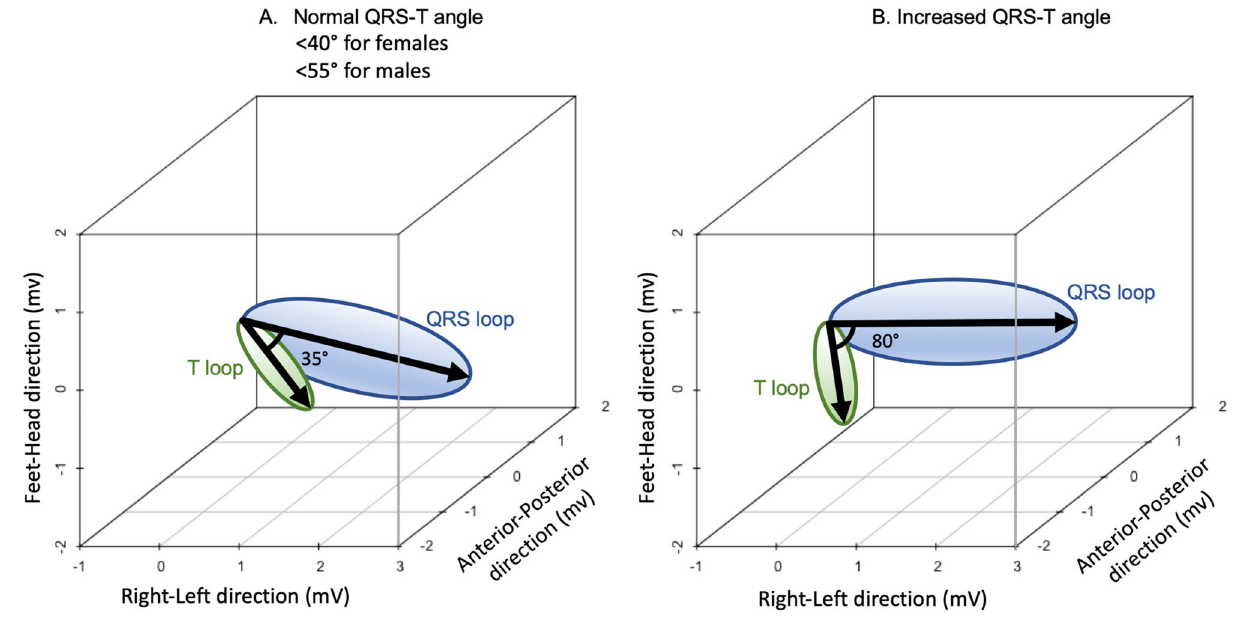
Figure 1. Schematic illustration of the QRS-T angle, a vectorcardiographic measure derived from a digital resting 12-lead ECG. The vectorcardiogram represents the electrical activity in millivolts (mV) in three dimensions along the left–right, feet-head and anterior–posterior axes. The QRS loop (blue) and T loop (green) represent the direction and peak magnitude of depolarization and repolarization, respectively, of the left ventricle. The thick arrows show the largest magnitudes of the respective loops. The angle in three-dimensional space between the largest magnitude of the QRS loop and T loop is referred to as the spatial peaks QRS-T angle. ( A ) Schematic example of a normal QRS-T angle of 35° in a healthy volunteer. ( B ) Schematic example of an increased QRS-T angle of (LVMI) or left ventricular end diastolic volume index (LVEDVI) greater than the 95% upper limit of normal for age- and sex-matched healthy volunteers with no history of cardiac disease or known risk factors according to published normal values 24 . The Clinical-Consecutive cohort underwent CMR to define measures known to associate with prognosis. These measures included left ventricular global longitudinal strain (GLS), which is a marker for impaired left ventricular function, left ventricular ejection fraction (LVEF), myocardial extracellular volume fraction (ECV), LVMI, LVEDVI, infarct size, and non-ischemic scar size. These measures were acquired and quantified according to clinical standards as previously described in detail 25 . Statistical analysis. Statistical analysis was performed in R version 3.4.3 (R Foundation for Statistical Computing, Vienna, Austria). The sex-specific cut-off for an increased derived spatial peaks QRS-T angle was defined as the upper limit of the 95% confidence interval of normal in the Healthy-Derivation cohort. The sen- sitivity to detect LVH by the QRS-T angle was evaluated in the Imaging-LVH and Clinical-Consecutive cohorts, respectively. The specificity to detect LVH by the QRS-T angle was evaluated in the Healthy-Validation and Clin-